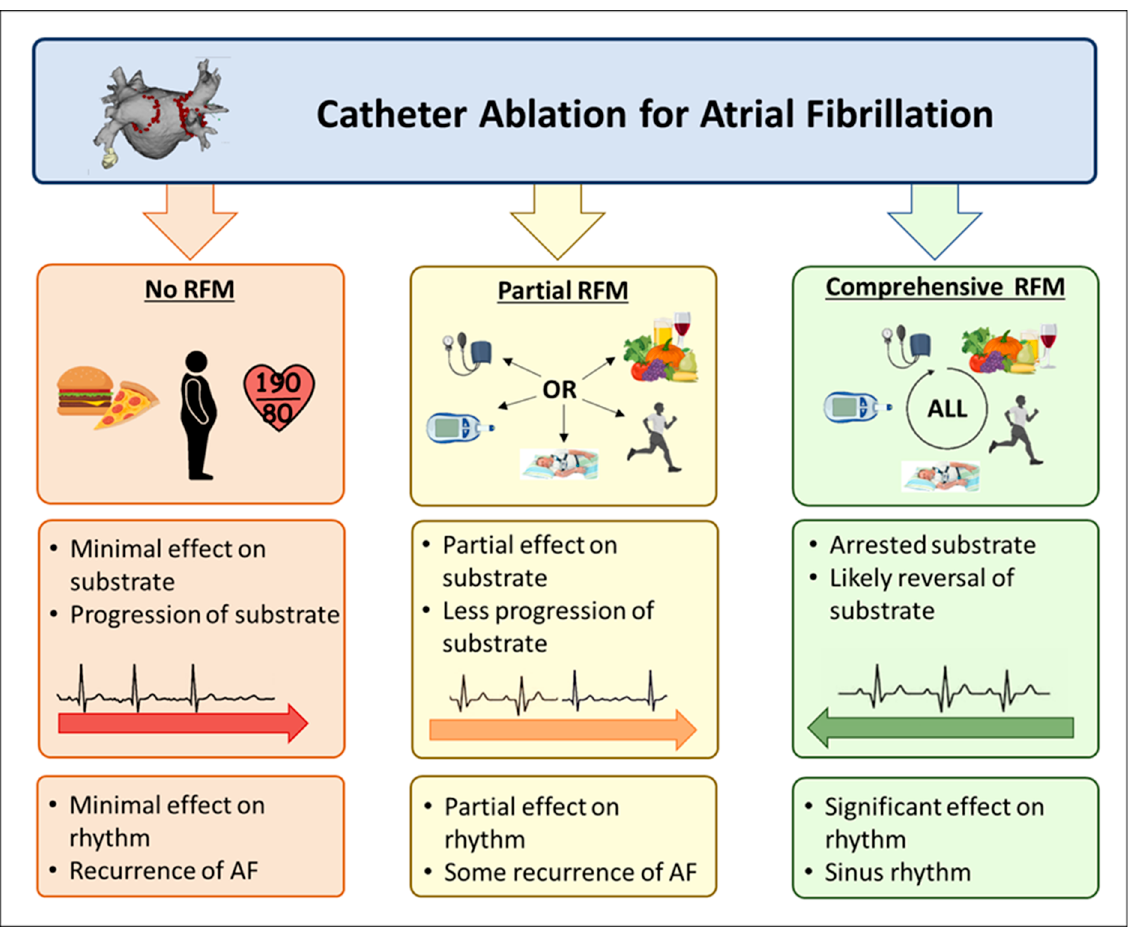
Figure 2. This figure highlights the additive benefit of risk factor management with AF ablation. Whether partial (some risk factors) or comprehensive (all risk factors) a benefit for risk factor man- agement is seen in patients with AF who require ablation.